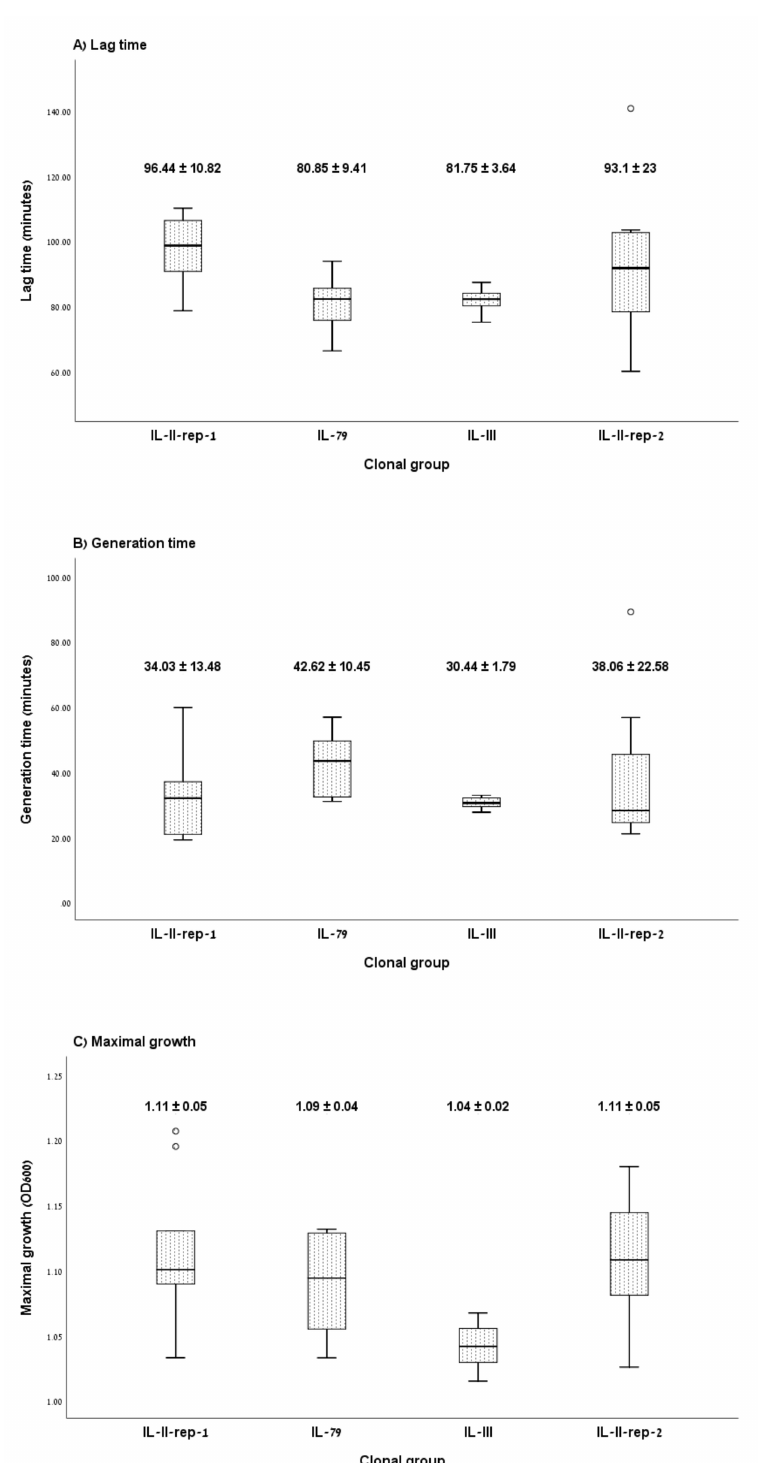
Figure 1. E ff ect of clonal group on in vitro fitness. ( A ) lag time, ( B ) generation time and ( C ) maximal growth after overnight incubation of isolates belonging to the carbapenem-resistant Acinetobacter baumannii (CRAB) clonal groups with low case fatality (IL-II-rep-1 and IL-79) and high case fatality (IL-III and IL-II-rep-2). Box plots depict the median (central horizontal lines), inter-quartile range (boxes) and minimal / maximal values (whiskers). Numerical values are the mean and standard